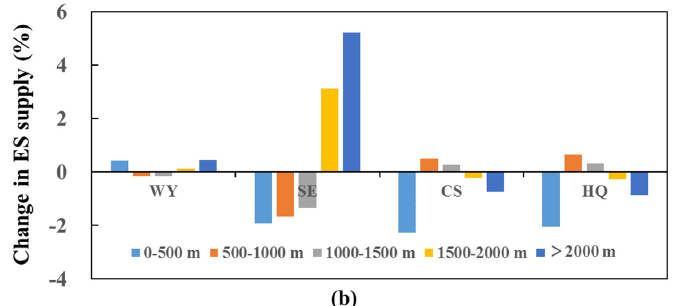
Figure 4. Variations in ecosystem services provision from 1995 to 2015 ( a ). Changes in ESs of past land use distribution (1995) in relation to current ESs (2015) at different altitudes ( b ). Negative change indicates a decline in specific ES, while positive change presents an increase in specific ES in ( b ).